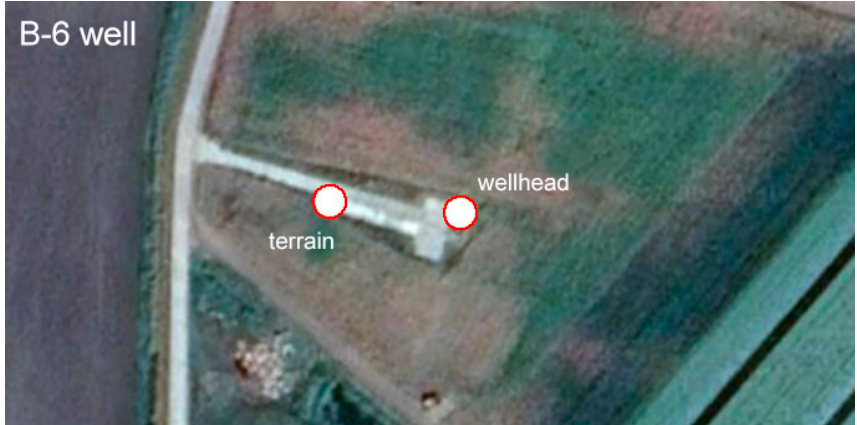
Figure 9. Location of measuring points at the B-6 well.